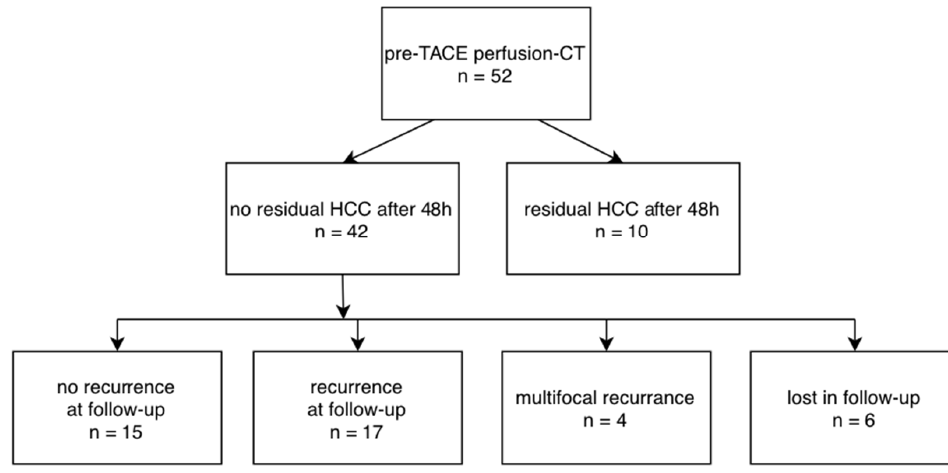
Figure 3. Flow-chart for included patients, results after TACE and follow-up.